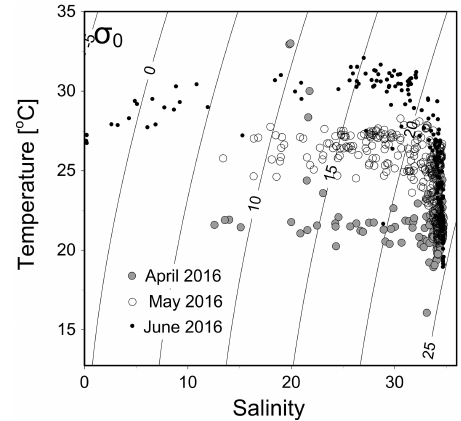
Figure 2. A temperature vs. salinity diagram during April– June 2016. Filled circles, open circles and dots are data from April, May and June cruises,